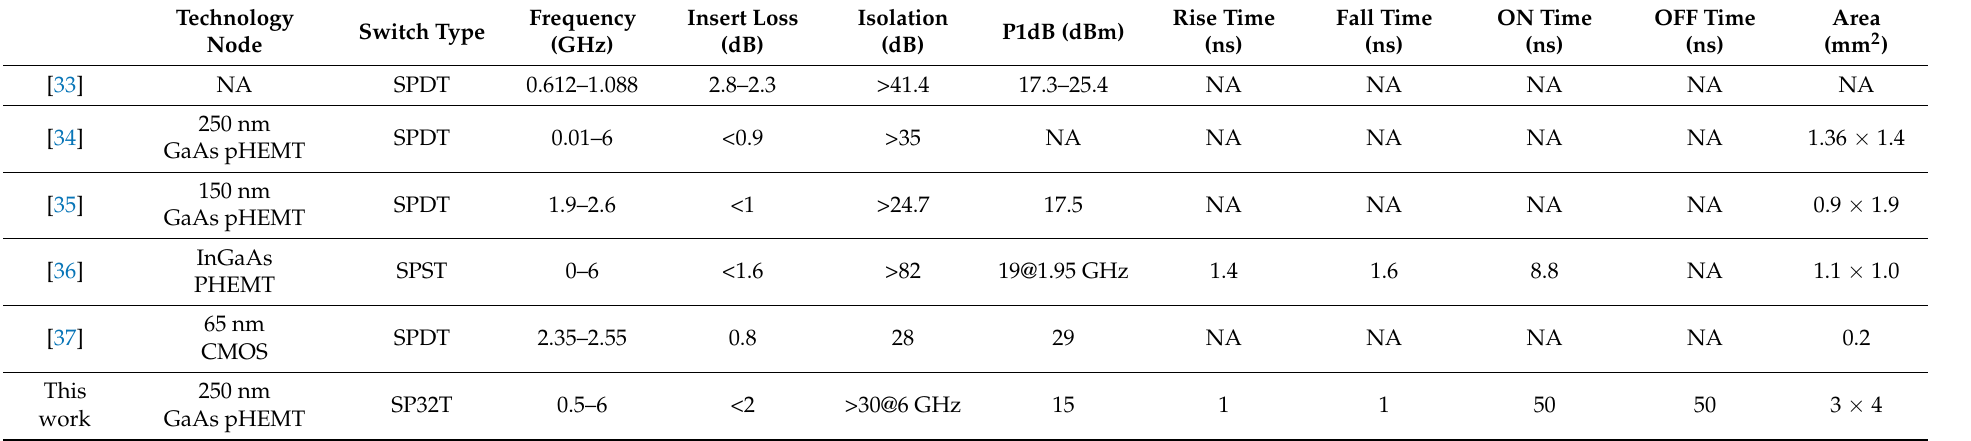
Table 1. Performance Summary and